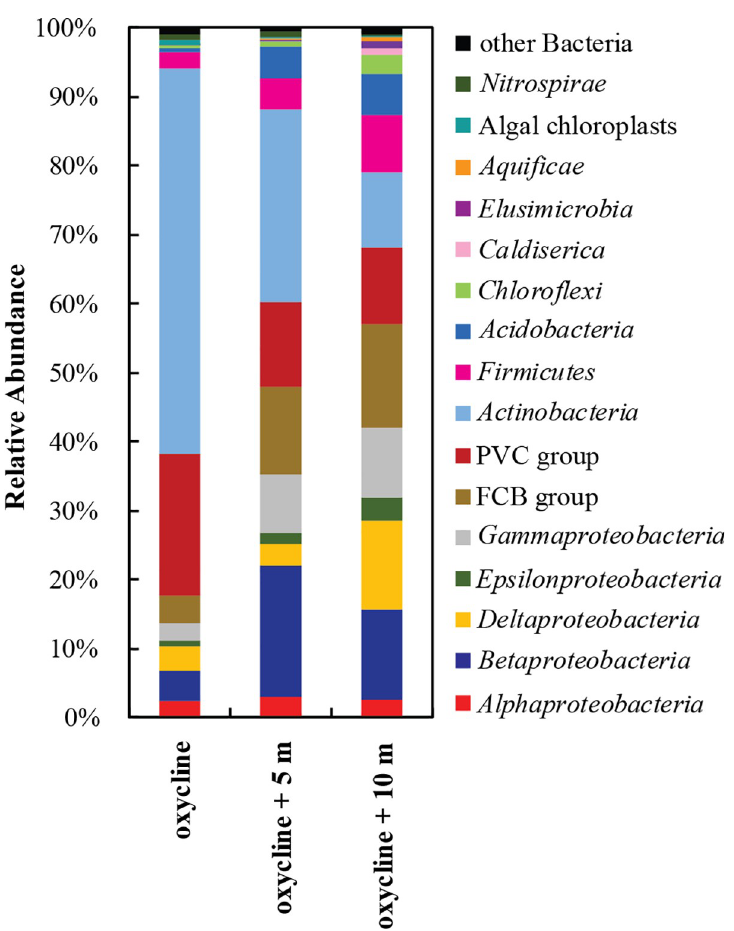
Fig 2. Overview of the total bacterial diversity in the Lake Pavin monimolimnion. Diversity was reconstructed from 16S rRNA gene amplicon libraries from 0 m, 5 m, and 10 m below the oxycline. FCB group = Fibrobacteres-Chlorobi- Bacteroidetes superphylum. PVC group = Planctomycetes-Verrucomicrobia-Chlamydiae superphylum. Clades containing less than 0.5% of sequences were classified as “other bacteria”.